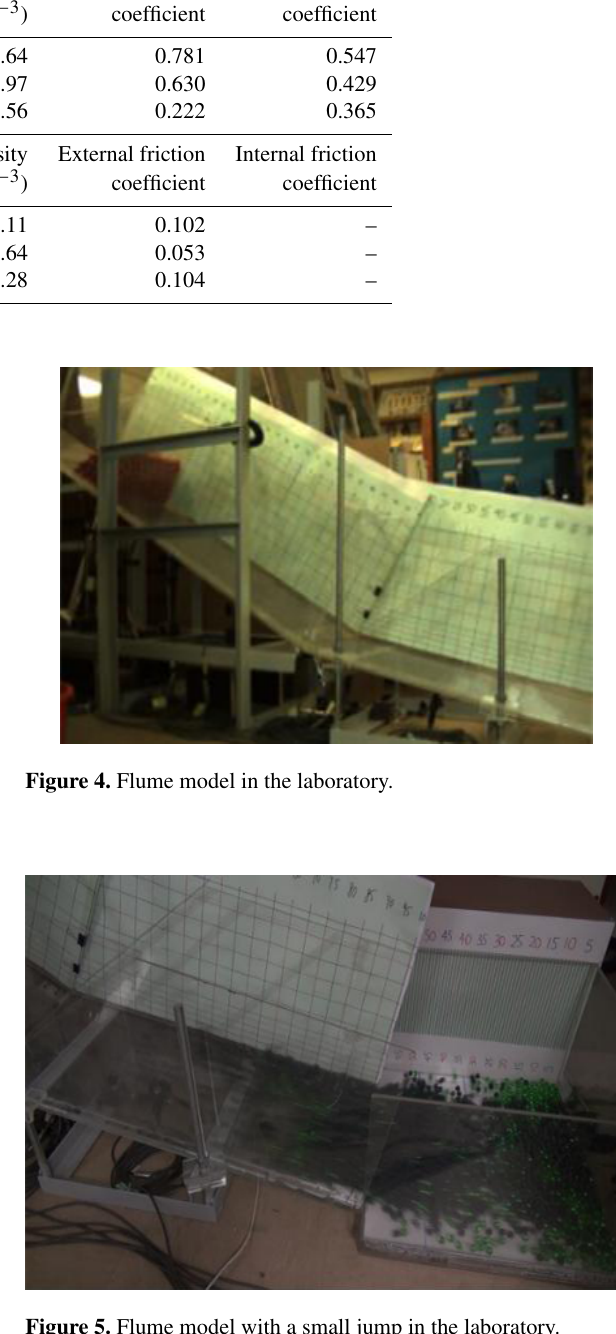
with a small flume jump, test 49 to test 55 were carried out for same material but different sizes of balls. In test 56 to test 63, a combination of two kinds of balls were tried. The last five tests were a combination of three kinds of